Question: What does this figure show? Answer in one sentence.
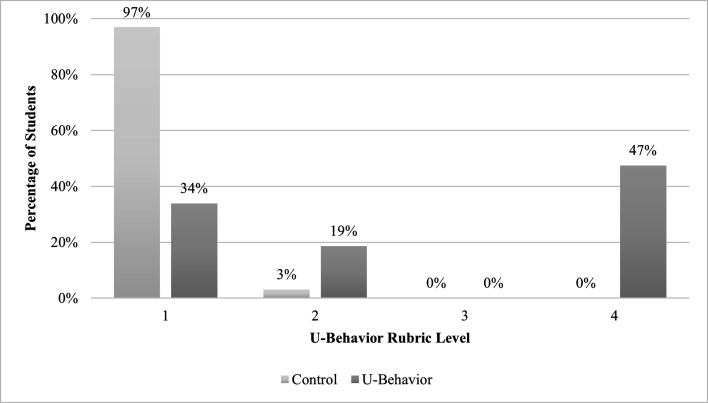
Answer: VMBS 100: distribution of UB-rubric scores. Note : Distribution of U-Behavior rubric levels in the control and U-Behavior conditions in VMBS 100. See also Table 4 for within-UB exam performance by rubric level.